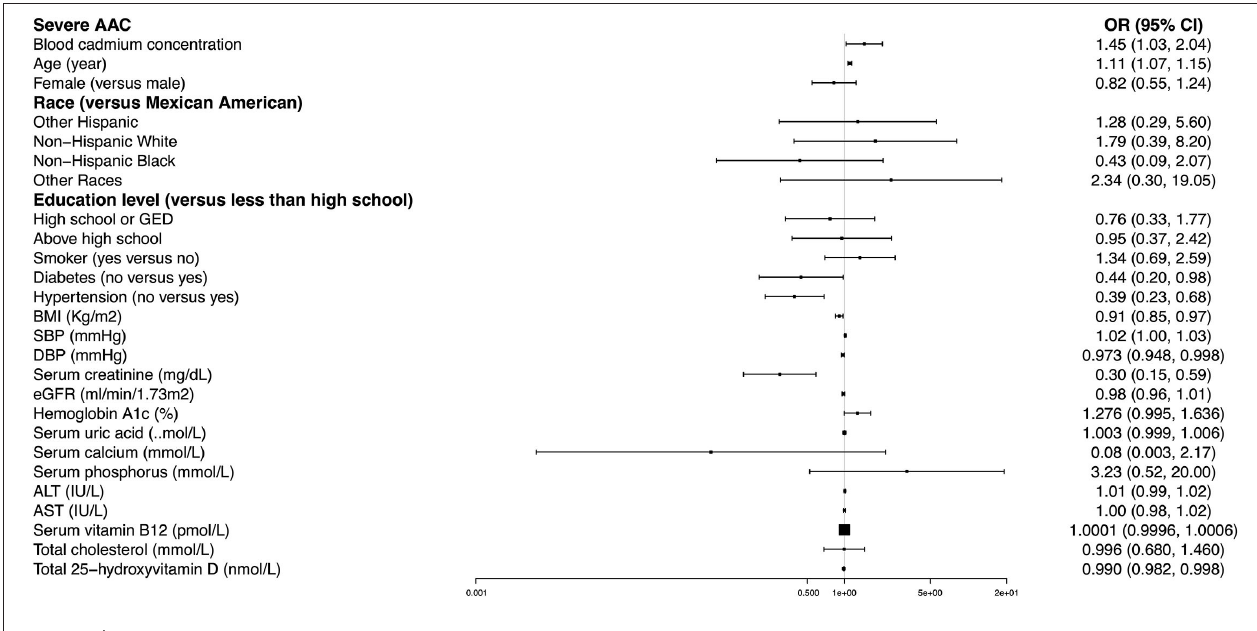
FIGURE 3 | Multivariate logistic regression models of severe AAC.